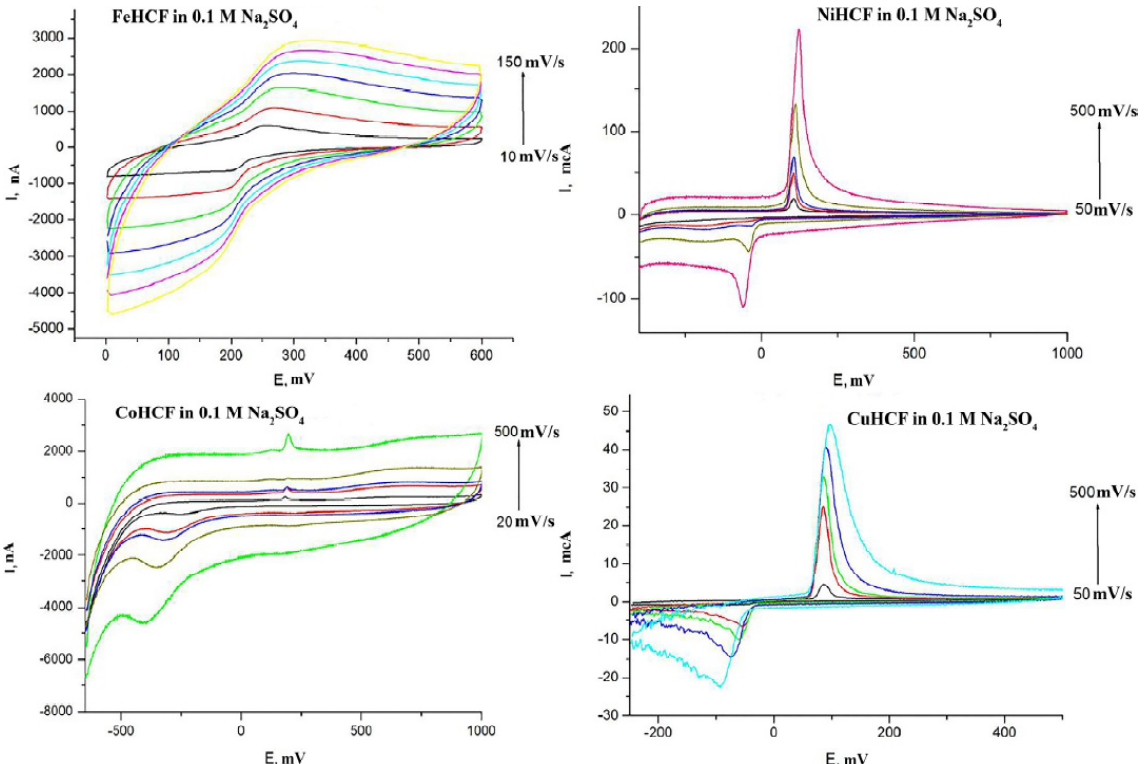
Fig. 9. Cyclic voltammograms of the substrate after the transfer of monolayers of nanoparticles of iron, nickel, cobalt and copper